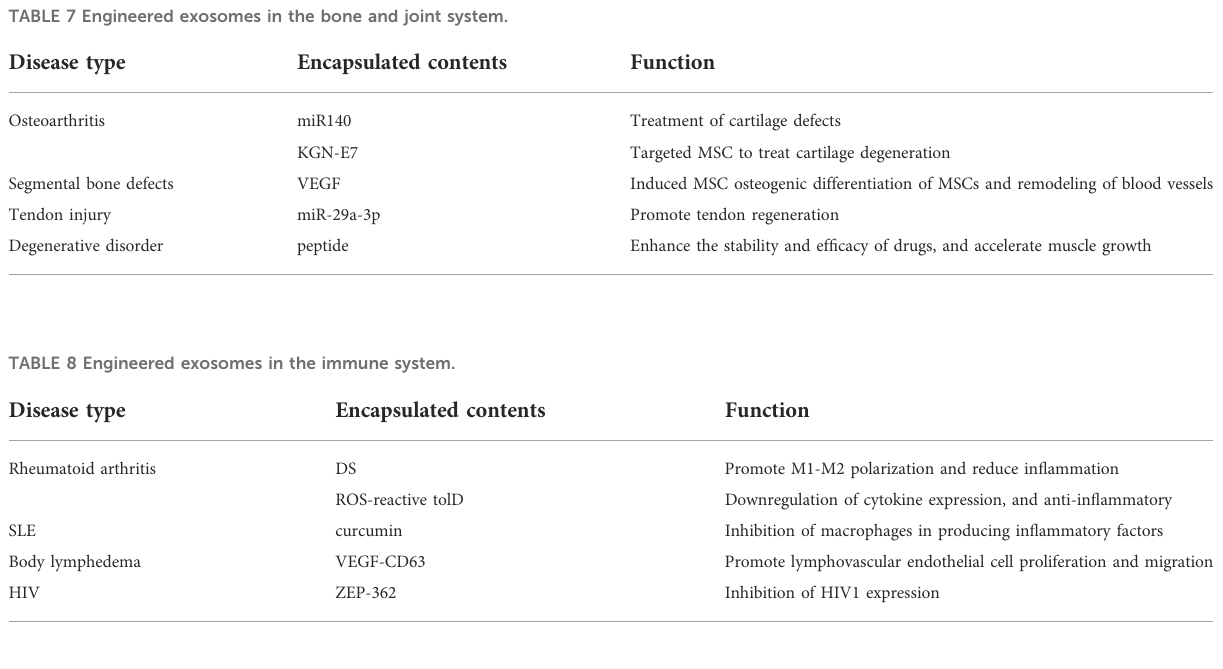
TABLE 7 Engineered exosomes in the bone and joint system.